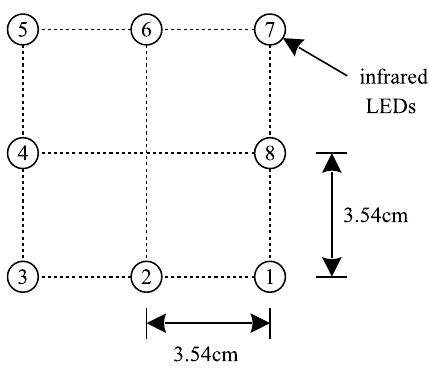
Figure 3. Eight infrared LED configuration.